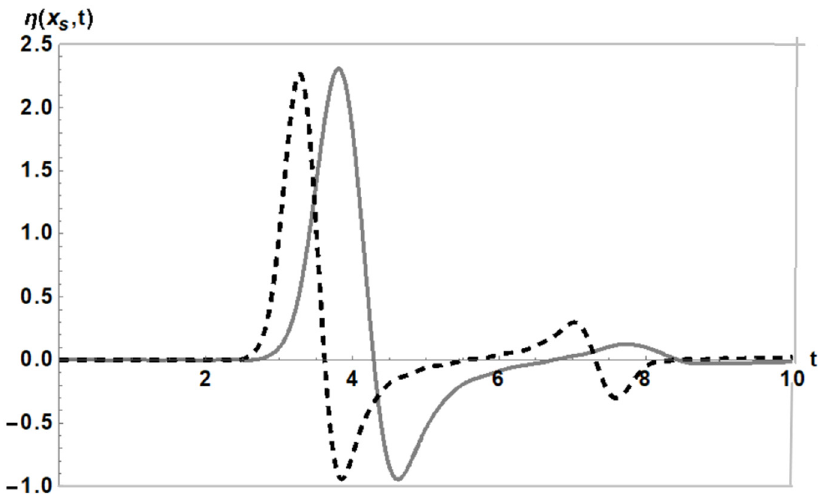
Figure 4. Dynamics of the height of the water splash above the still water level at the moving boundary for the smooth case ( α = 1, solid line) and for the case when the sloping beach has a vertical step down to the flat horizontal seafloor ( α = 0.5, dashed).